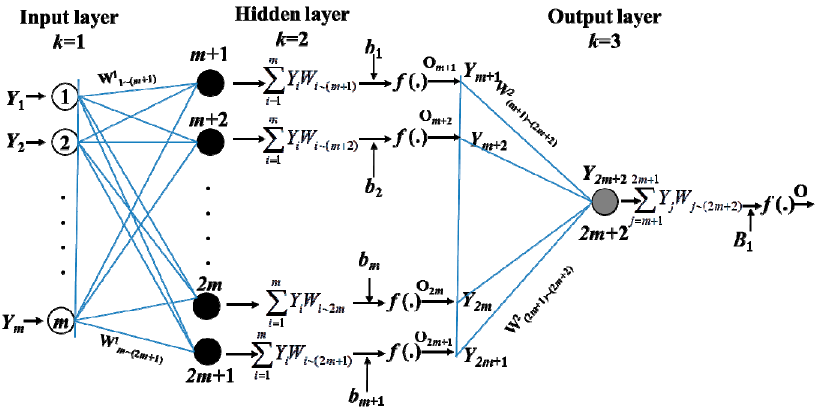
Figure 4. Schematic diagram of BP neural network.